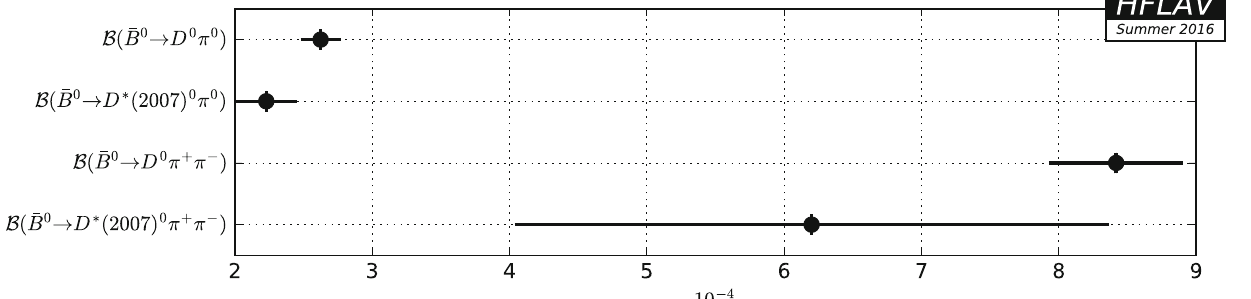
Fig. 68 Summary of the averages from Table 93